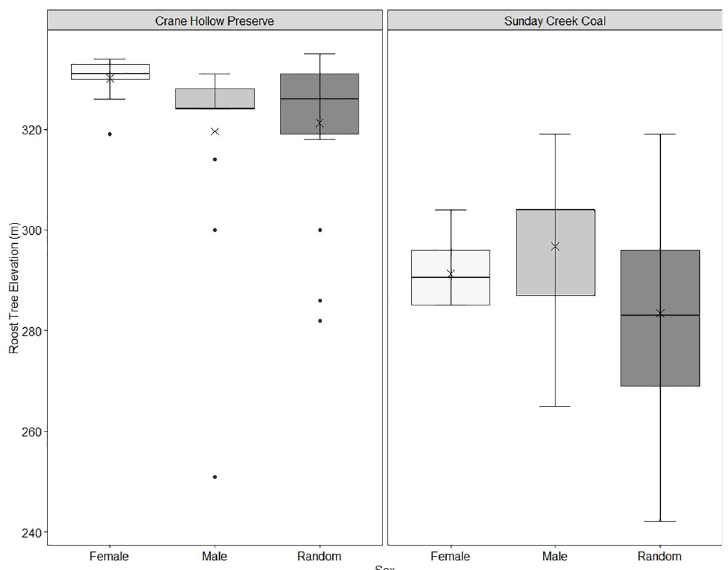
Fig 2. Box and whisker plot showing male (light grey) and female (white) eastern red bats roosting at different elevations than randomly sampled trees (dark grey) at Crane Hollow Preserve and Sunday Creek Coal study areas in southeast Ohio, 2016–2019. Females roosted at higher elevations than males at the preserve, but sexes roosted at similar elevations at the reforested mine. Medians are depicted by the solid line, means are represented by the X’s, and outliers are depicted as black dots. Quartiles 2 and 3 are represented by the box and quartiles 1 and 4 are represented by whiskers.